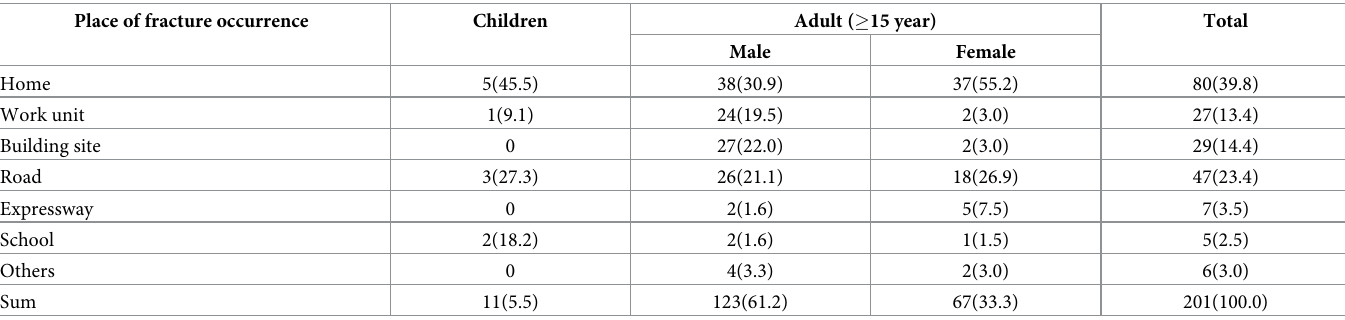
Table 3. The place of foot fracture occurrence in 2014 (n,